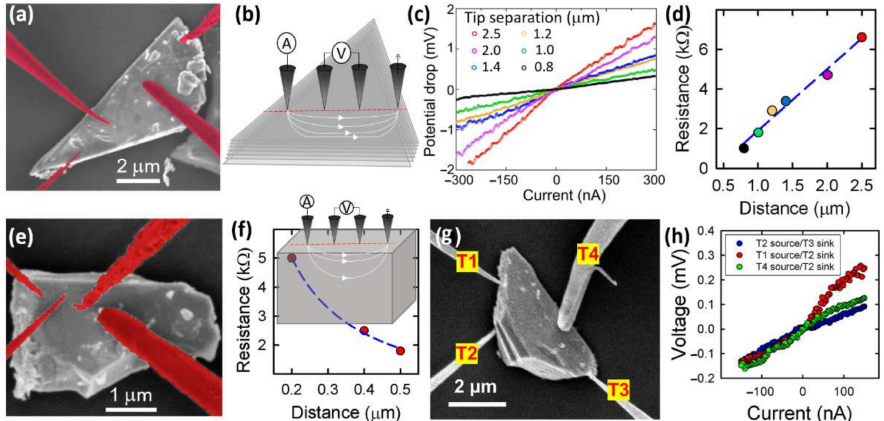
Figure 4. ( a ) SEM image of a methyl-terminated germanane microcrystallite contacted with four STM tips. The STM tips have been colorized to be better differentiated from the crystallite. ( b ) Schematic of the current flow with a compressed current distribution due to the limited thickness of the crystallite. ( c ) V ( I ) characteristics measured for six different equidistant tip separations. ( d ) Linear variation of the four-point resistance as a function of the probe separation. The dashed line corresponds to the best fit. ( e ) SEM image of a methyl-terminated germanane microcrystallite contacted with four STM tips and ( f ) related four-point resistance. The dashed line corresponds to the best fit, which is inversely proportional to the equidistant probe spacing. Inset: Schematic illustration of the current flow pattern for a thick microcrystallite. ( g ) SEM image of a methyl-terminated germanane microcrystallite contacted with STM tips from different facets and ( h ) corresponding four-point resistances as a function of the position of the source tip and the grounded